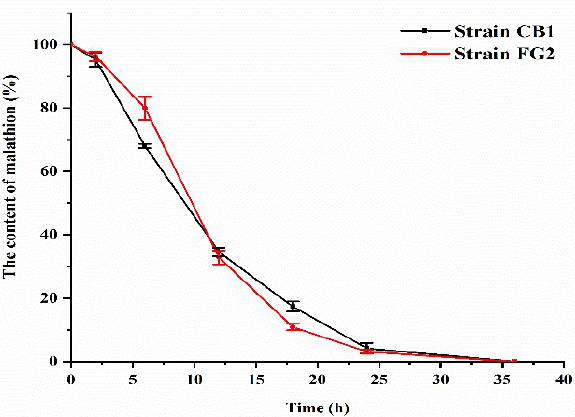
Figure 1. The geographic map of sediment sample collection sites.